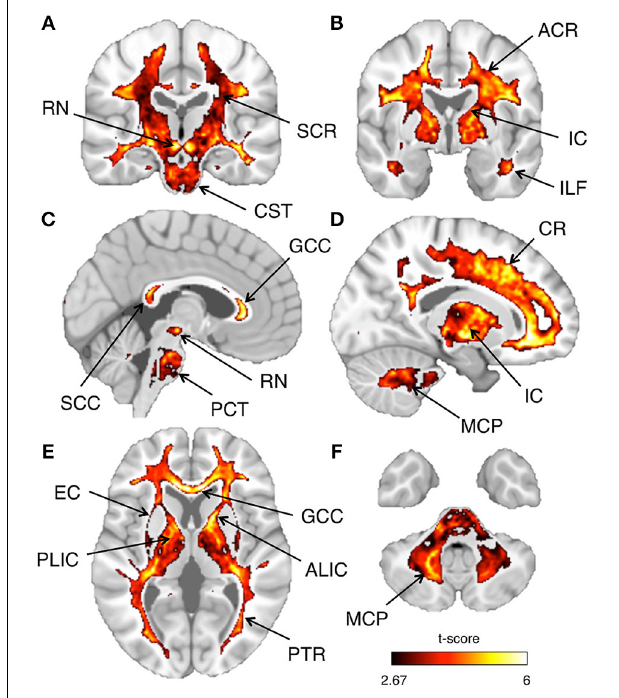
FIGURE 12 | Inter-subject reproducibility: whole-brain analysis. The across-subject reproducibility of the T1-w/T2-w images were evaluated on a voxel-wise basis. The maps illustrate regions with significant t-scores ( p < 0 . 05 FDR-corrected) over coronal, sagittal, or axial sections of a standard MNI template. The following sections, referring to the MNI coordinate system, are shown: x = 3 (A) , x = 17 (B) , y = − 20 (C) , y = − 2 (D) , z = 5 (E) , z = − 39 (F) . Selected structures with significant t-score are indicated using arrows: anterior corona radiata (ACR), superior corona radiata (SCR), corona radiata (CR), anterior limb internal capsule (ALIC), posterior limb internal capsule (PLIC), internal capsule (IC), external capsule (EC), posterior thalamic radiation (PTR), genu of corpus callosum (GCC), splenium of corpus callosum (SCC), inferior longitudinal fasciculus (ILF), corticospinal tract (CST), pontine crossing tract (PCT), middle cerebellar peduncle (MCP), and red nucleus